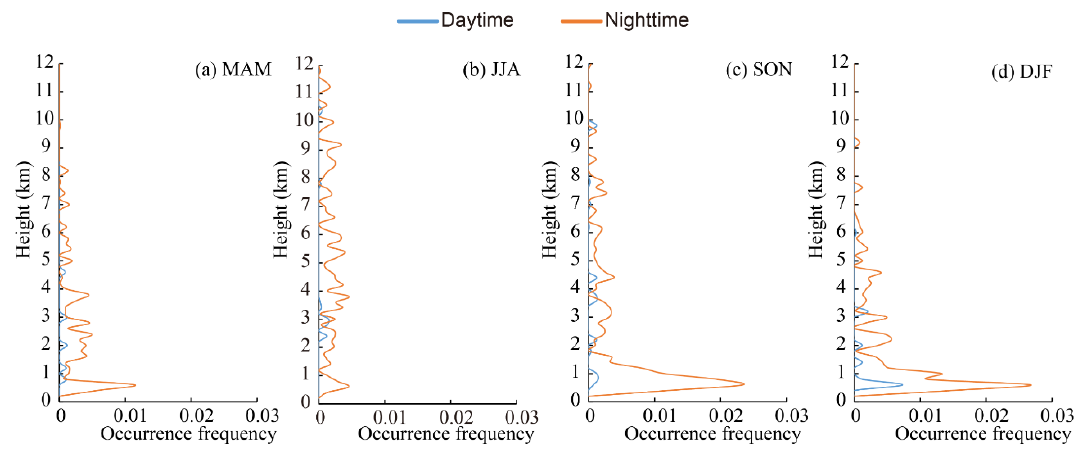
Figure 8. Vertical distribution of occurrence frequencies of clean continental layer in the daytime and nighttime in the Aral Sea region from CALIPSO observations for four seasons.